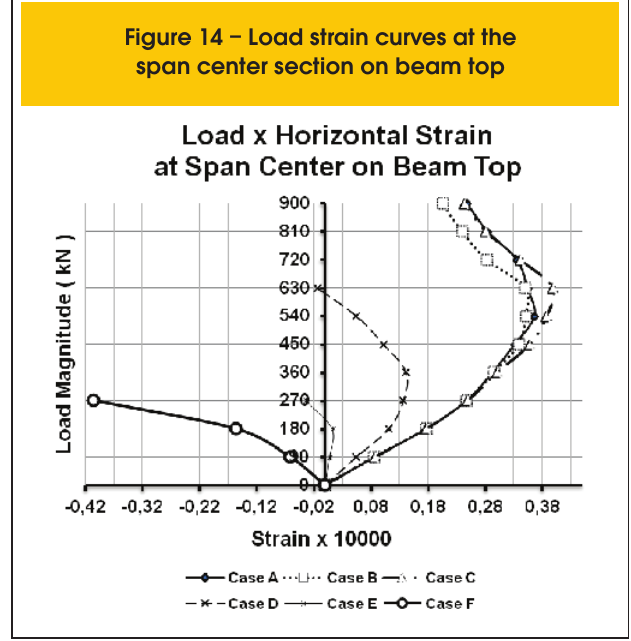
Figure 12 – Vertical stress distribution along the longitudinal direction on beam top